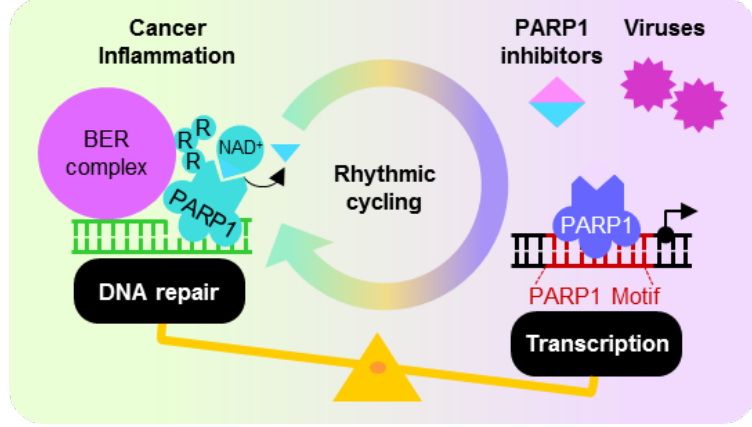
Figure 4. PARP1 DNA repair and motif-dependent transcription is intricately